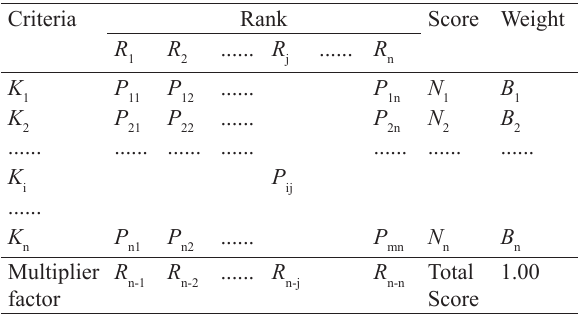
Tabel 3 Calculation of criterion weight according to the Eckenrode method